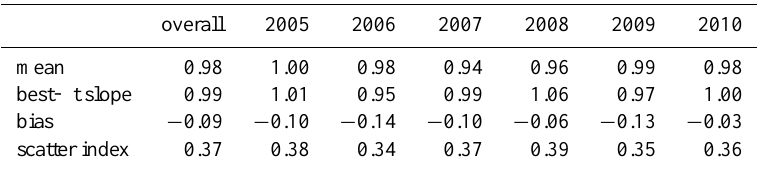
Table 1. Statistics for the comparison of the significant wave height in the Adriatic Sea out of the ENVISAT altimeter and the corresponding model data. The considered period is 2005–2010. The results are shown for the overall period and for each single year. The mean satellite value is shown. The comparison is model vs. altimeter. Values are in metre. The scatter index is the ratio between the mean square error and the mean value.